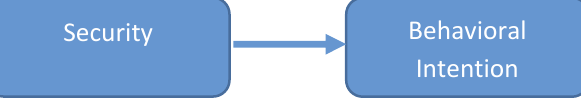
Fig. 4. Security relations and Behavioral Intention Source (Tarhini et al.,